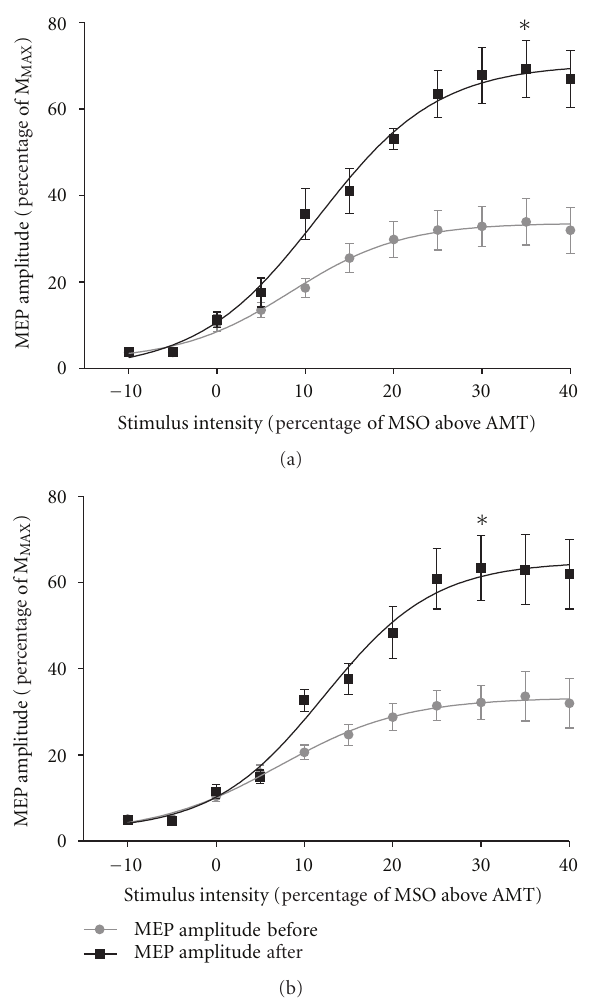
Figure 3: Mean ( ± SE) MEP (% of M MAX ) recruitment curves for the right rectus femoris for the control group (a) and WBV group (b), respectively. The grey curve represents MEP data collected during pretesting, and the black curve represents data collected during posttesting. AMT is represented as x = 0, with data taken at stimulus intensities 10% of maximum stimulator output (MSO) below AMT ( x = − 10), increasing in increments of 5% of MSO until MEP amplitude (% of M MAX ) reached a plateau (peak height). There were no di ff erences in V 50 ( P = 0 . 988) or peak height ( P = 0 . 419) of the curve between groups at baseline. However, there were 64.77% and 73.93% increases in V 50 ( P = 0 . 006) and 105.16% and 112.22% increases in peak height ( P < 0 . 001) following the intervention, as denoted by an asterisk. There were no significant di ff erences between groups for either V 50 ( P = 0 . 845) or peak height ( P = 0 . 888) following the intervention.